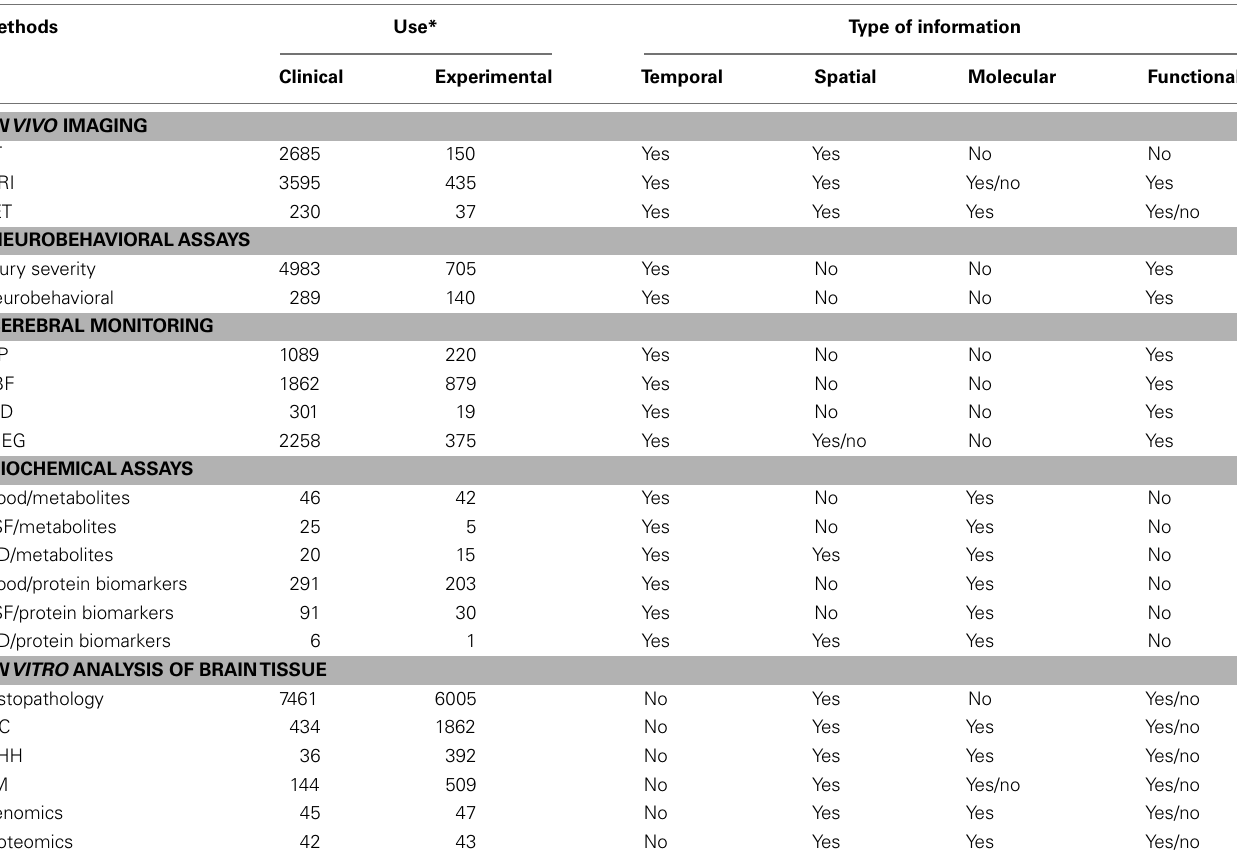
Table 1 | Clinical vs. experimental research: a comparison of methods.